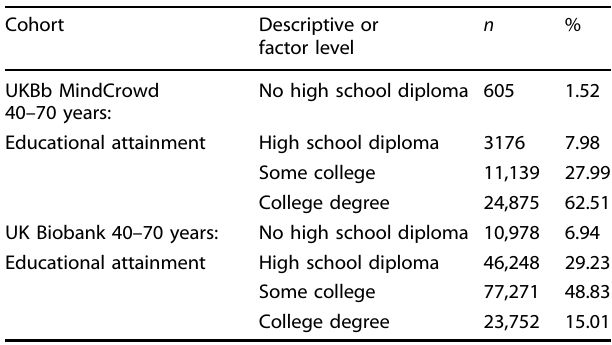
Table 3 for a summary of MindCrowd ’ s results.